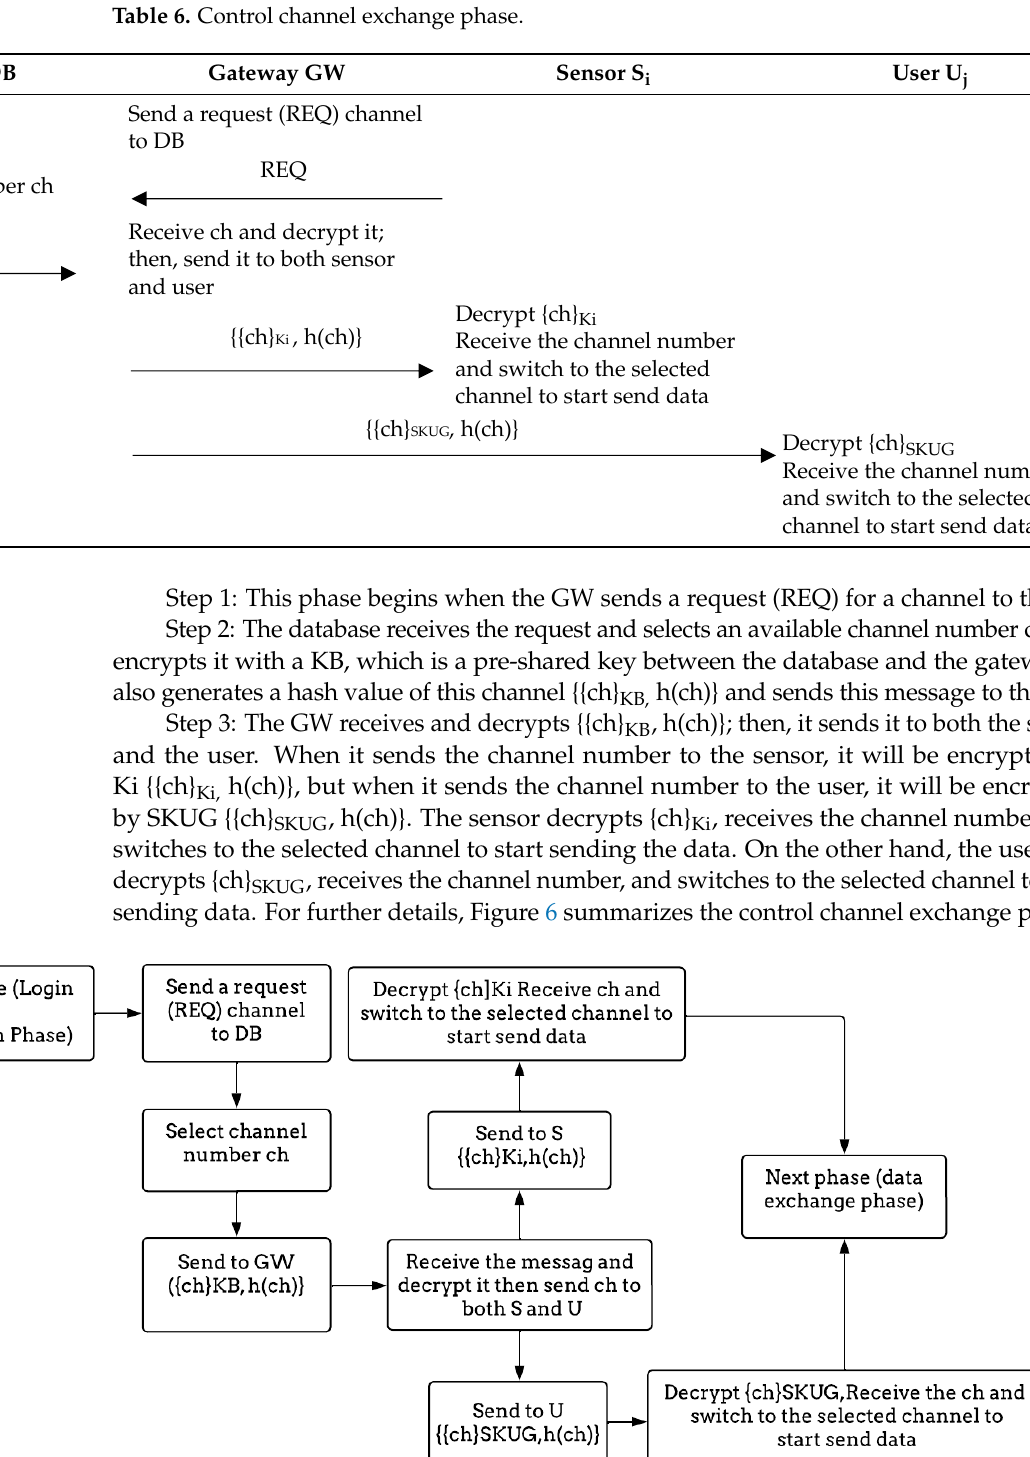
Table 7. Data exchange phase. Sensor S i